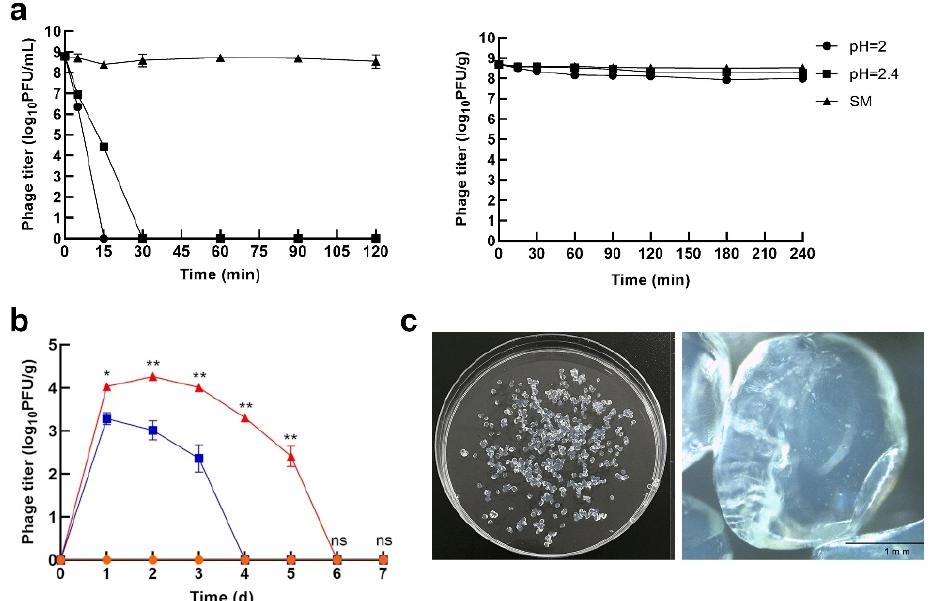
Figure 3. Microencapsulated phages show prolonged stability in gastrointestinal environments and high therapeutic efficiency in treating Escherichia coli O157:H7 infection. ( a )—the comparison of free phages’ and microencapsulated phages’ stability in simulated gastrointestinal conditions. Encapsulated phages remained active two times longer (30 min) than free phages (15 min). ( b )—Phage titer in the feces; encapsulated phages remained active for 6 days, while free phages were detected up to 4th day (* p < 0.05; ** p < 0.01). ( c )—Images of microcapsules on the plate and imagined using the optical microscope [108]. Panels were adapted from Yin et al. [108], based on the CC BY 4.0 License.